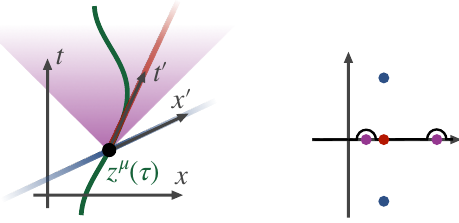
Figure 2 . Left : localization properties of some simple scalar-like currents. In the rest frame of a worldline element, with coordinates ( x 0 , t 0 ) , the spatial current (blue) is localized on the spacelike slice t 0 = 0 , the retarded temporal current (red) is localized on the timelike ray x 0 = 0 , t 0 > 0 , and the retarded inhomogeneous current (purple) is contained on or within the forward light cone. Right : essential singularities in the complex ω plane for the spatial current, temporal current, and the integral in (4.5) for the inhomogeneous current, for a velocity with k · v > 0 . We also show an integration contour corresponding to retarded boundary conditions for the inhomogeneous